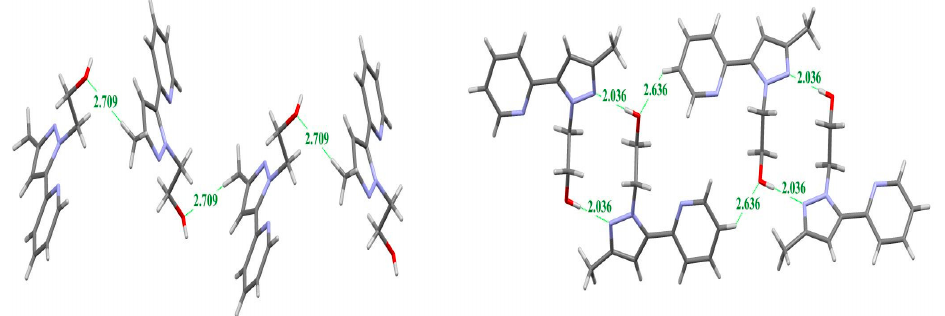
Figure 3. Representation of the molecular arrangement enhancing the intermolecular interactions viewed along a-axis ( left ) and b-axis ( right ). Atoms colours codes: O (red), N (blue), C (grey) and H (white).